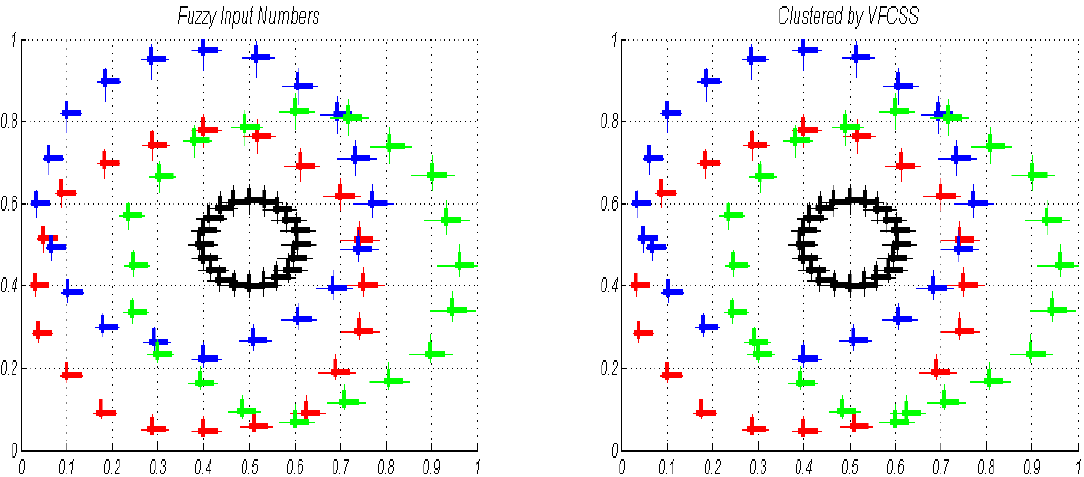
Figure 4. Proposed VFCSS clustering over input non-symmetric LR-type fuzzy numbers include four interference classes red, blue, black and green with (20,20,20,20) members, (first step of state 2).